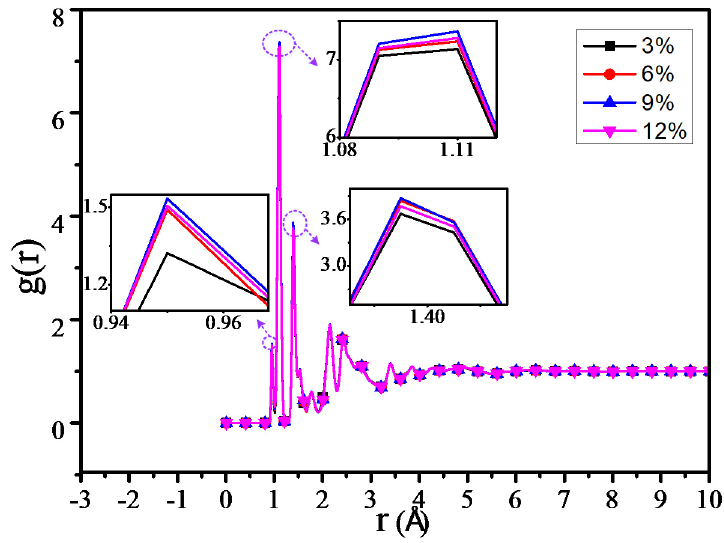
Figure 10. Radial distribution function (RDF) of all atoms of different models.